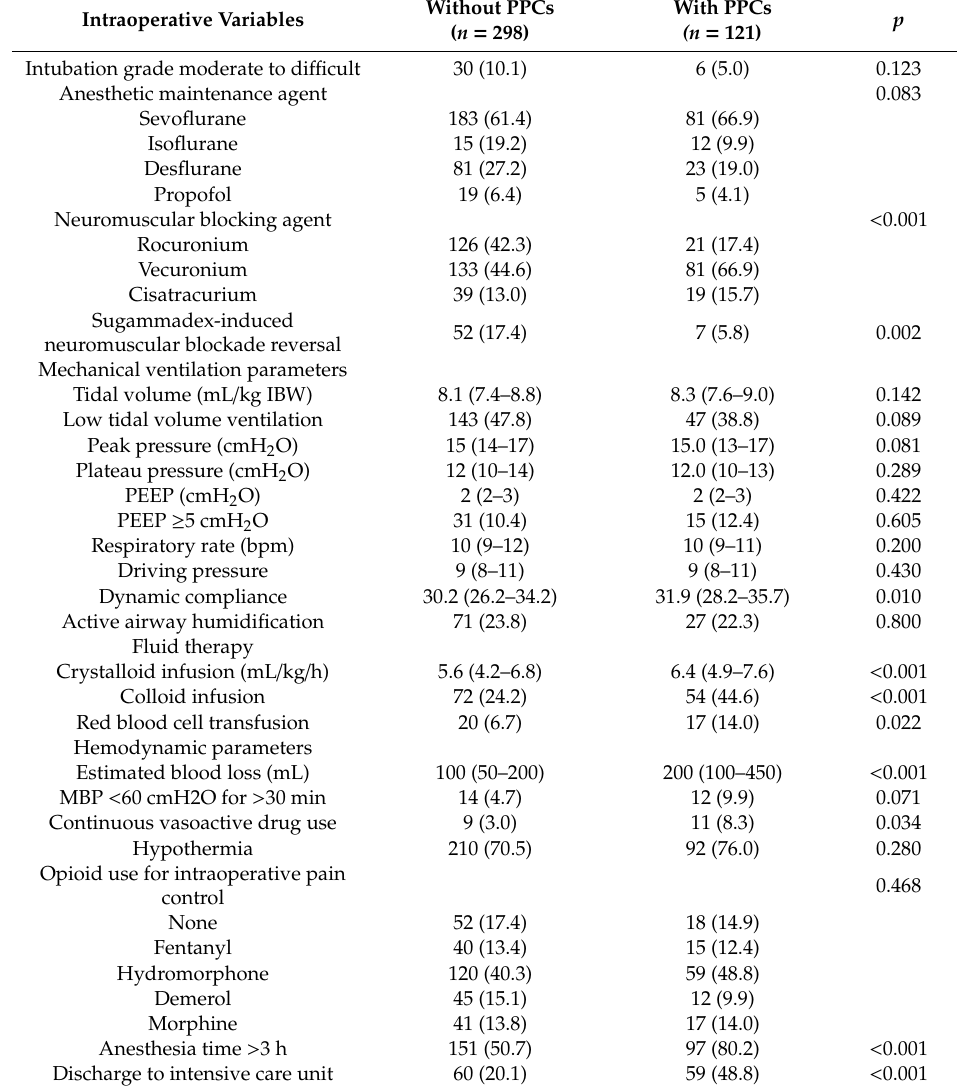
Table 2. Intraoperative variables of the